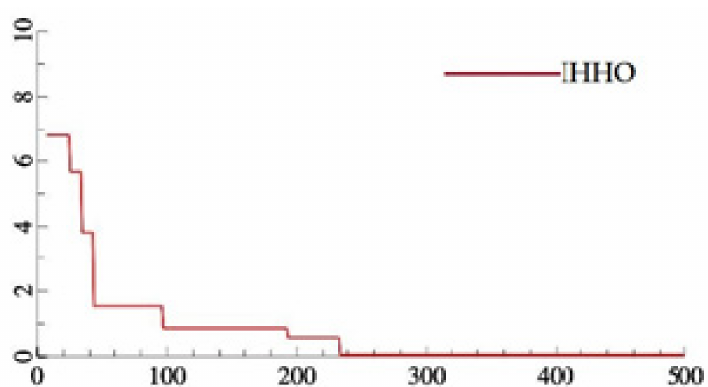
Figure 7. Iterative Graph of Improved Harris Hawk Optimization